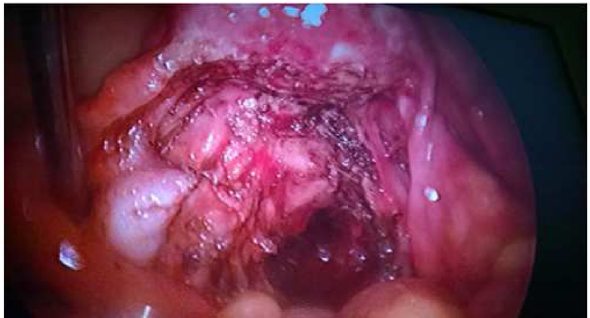
Figure 7. Complete removal of all superficial and hidden lesions at the pouch of Douglas. Image is from surgery performed by the